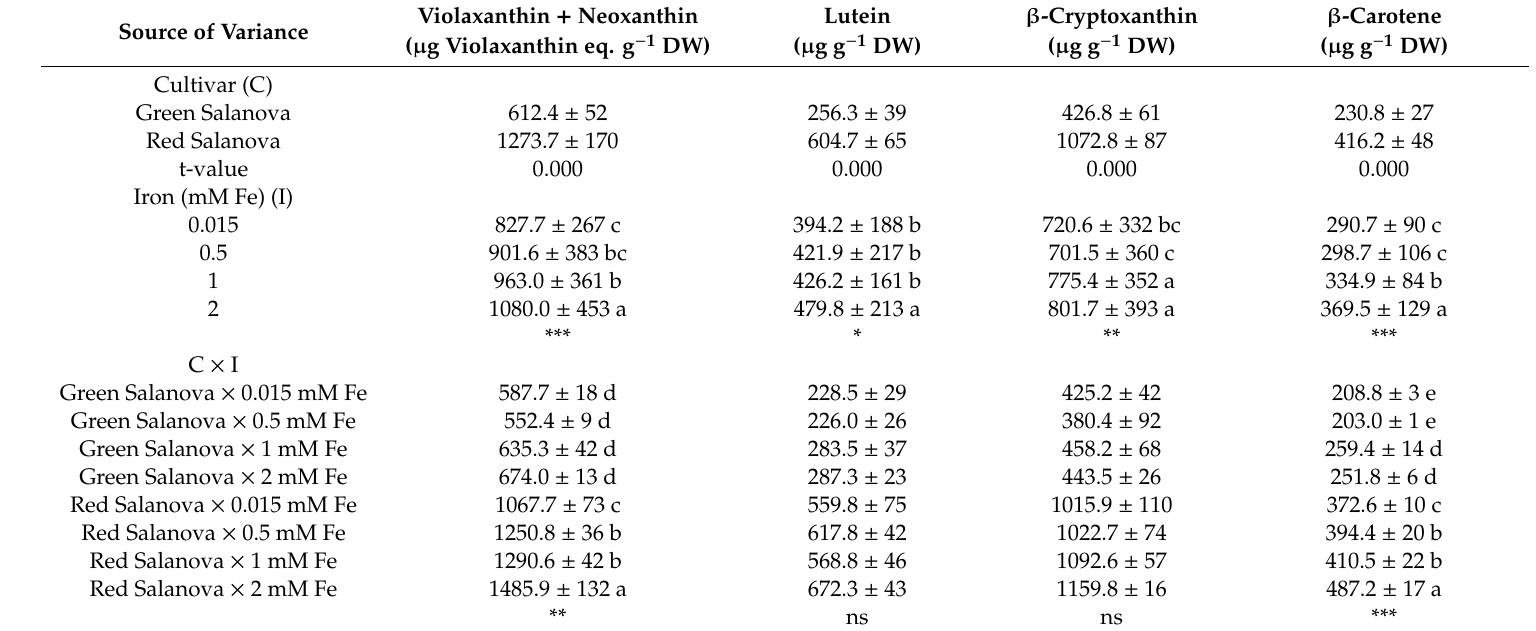
Table 4. Analysis of variance and mean comparisons for target carotenoids in green and red Salanova butterhead lettuce grown under increasing Fe concentration in the nutrient